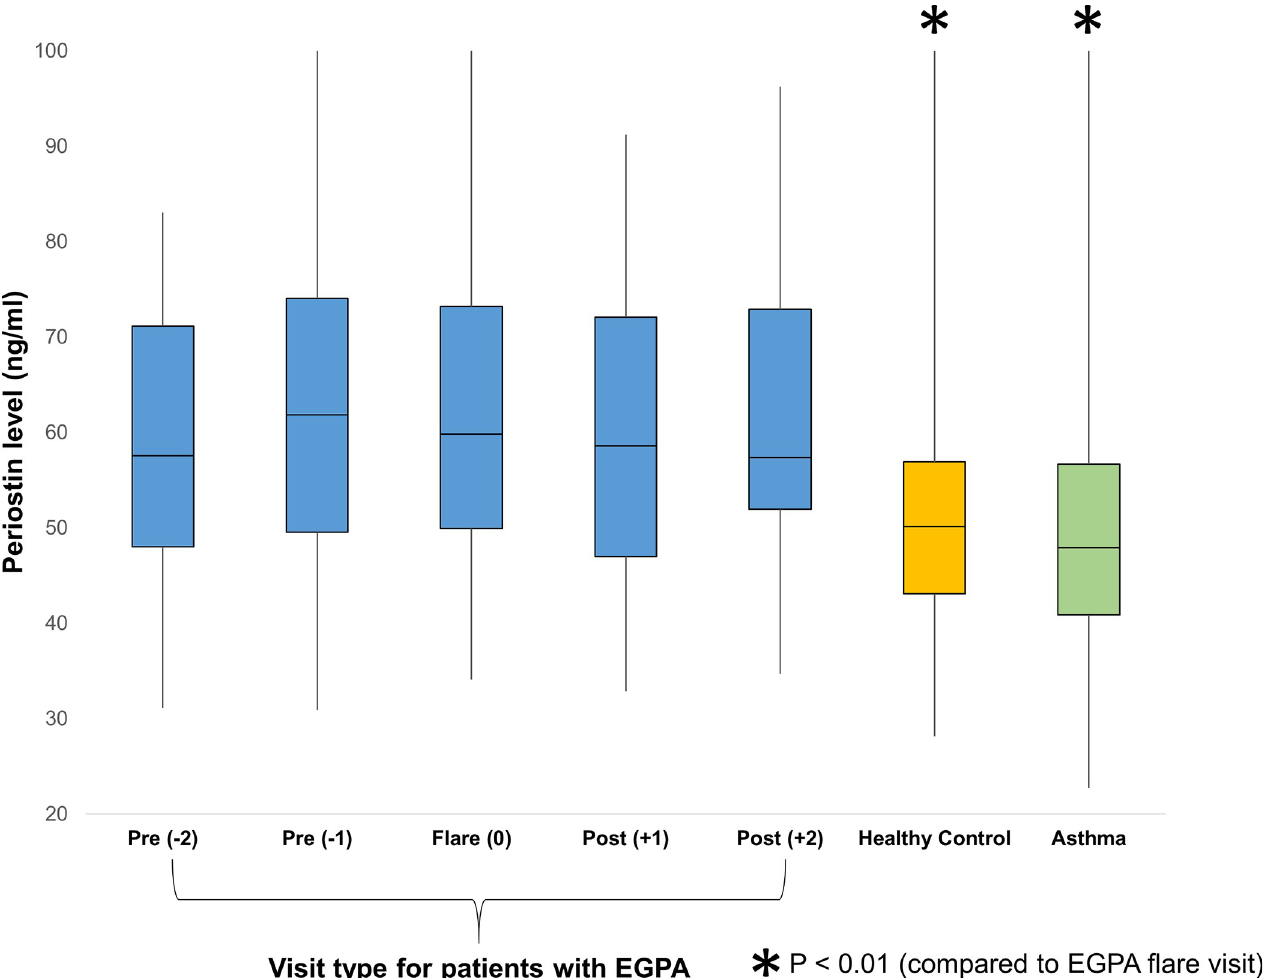
Fig 1. Median periostin level at all visits of patients with eosinophilic granulomatosis with polyangiitis (EGPA) compared to control groups. Visit types are arranged relative to the relapse visit (0). Periostin levels were stable across visits regardless of disease activity status. Levels for healthy control and asthma groups were obtained from previously-published data using same assay and were significantly lower compared to periostin levels of patients with EGPA who were relapsing (p < 0.01).